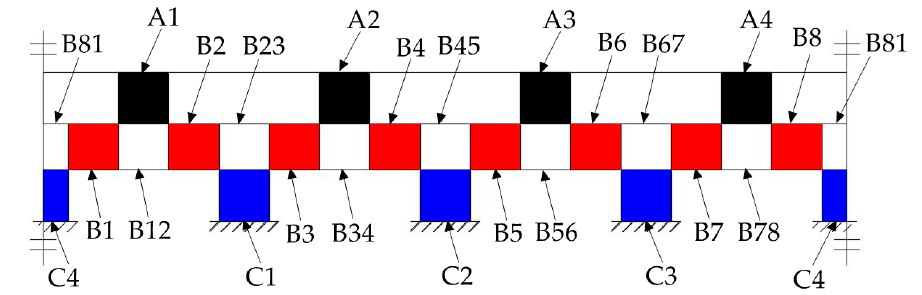
Figure 11. The unfold of the cylinder-shaped elastic structural body.